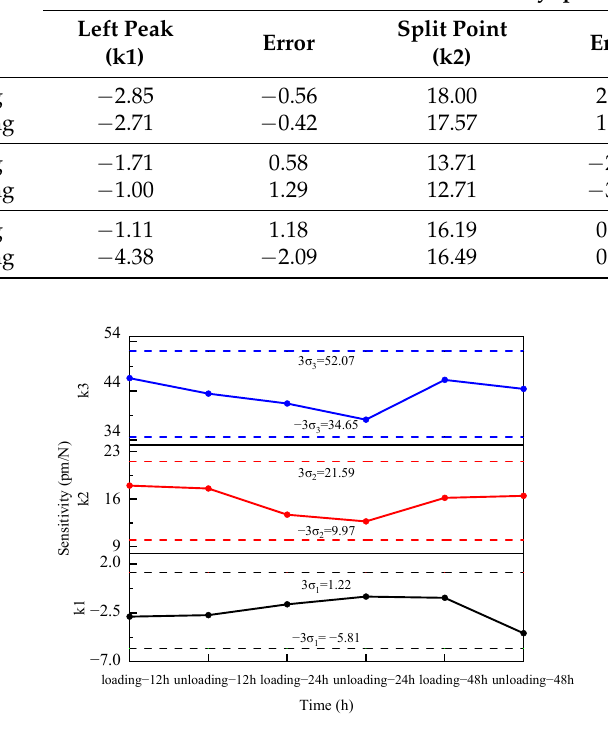
Figure 14. Residual distributions of k1, k2 and k3.